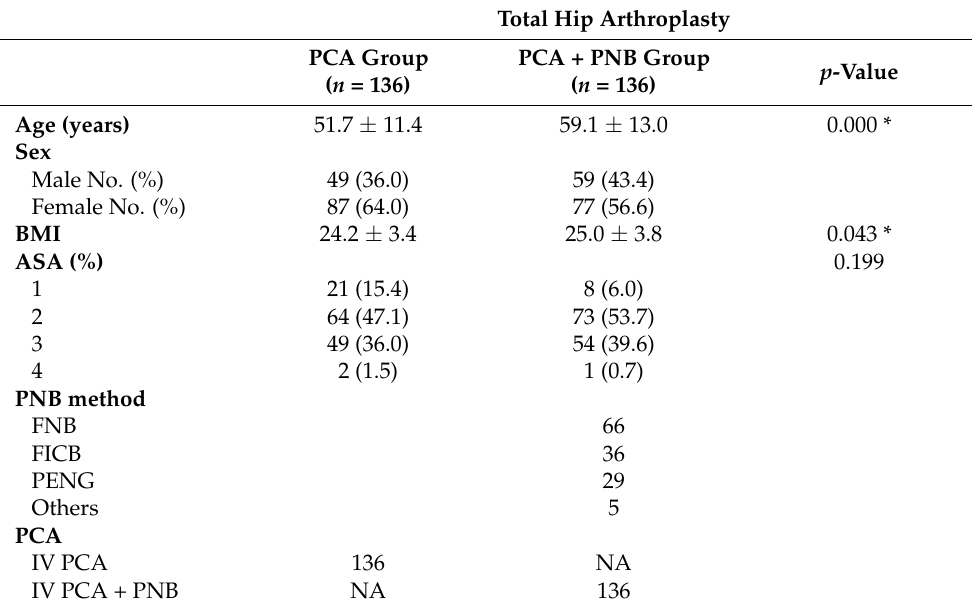
Table 1. Baseline characteristics of the patients undergoing total hip